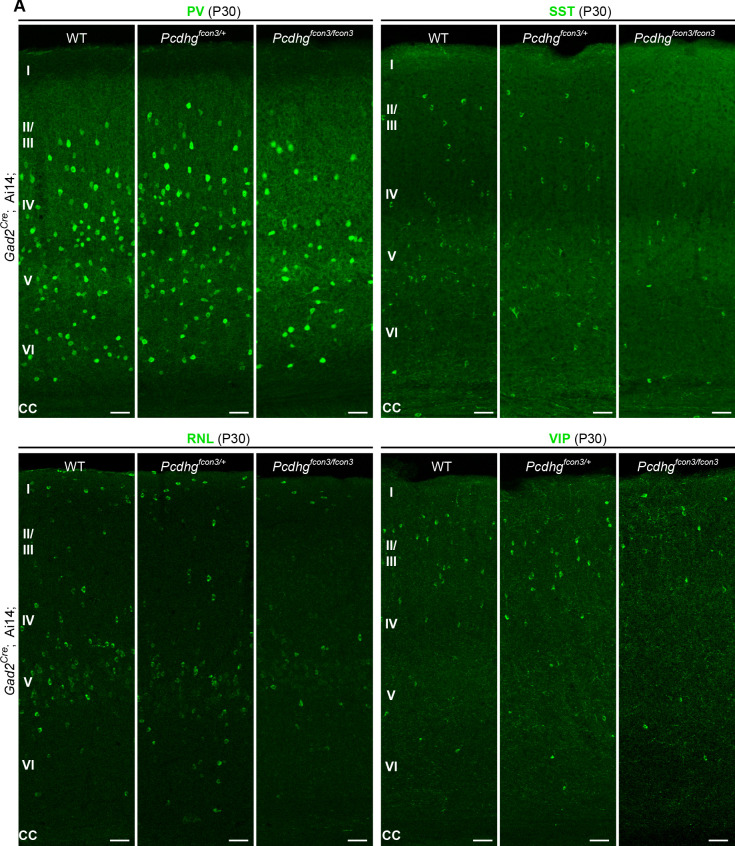
Reduced number of GABAergic cIN subtypes in Pcdhg-deficient mice.(A) Representative photographs of the primary visual cortex (V1) in Gad2Cre;Ai14;Pcdhg WT, Pcdhg heterozygote and Pcdhg mutant mice. Gad2Cre;Ai14 sections were stained for PV, SST, RLN or VIP. Scale bars, 50 μm.